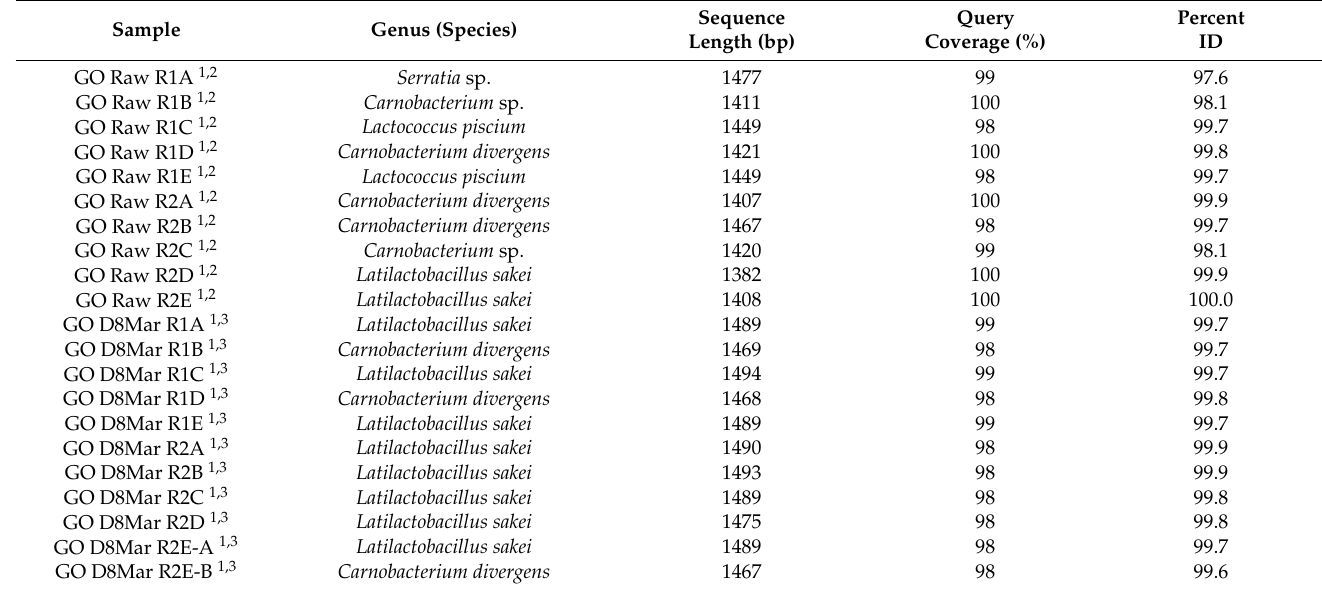
Table 1. Bacterial isolates identified from Greater Omaha Packing Co. Inc. (GO) based on 16S rRNA gene sequencing analysis of isolates obtained from raw beef (Raw) and marinaded beef after 8 days of drying (D8) for trial 1 (R1) and trial 2